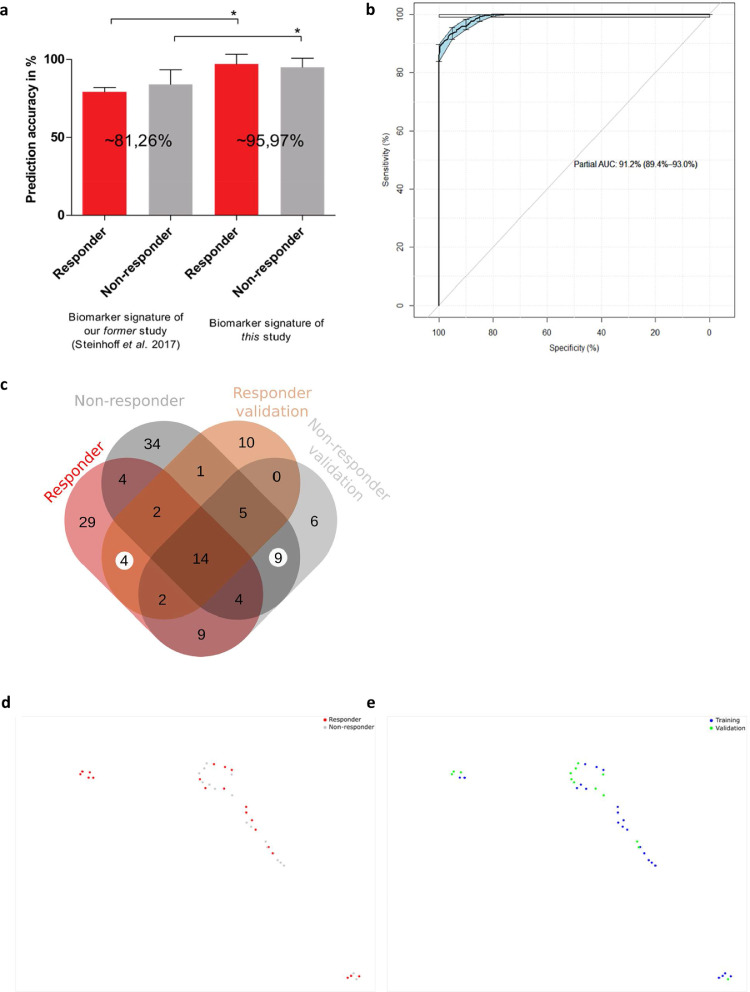
Patient stratification to responder and non-responder. Clustering and SNP signature comparison for the analysis and validation cohort.a: Machine learning accuracy comparison for the supervised prediction of the patient responsiveness using only preoperative data. Results are obtained after feature selection and subsequent prediction with two independent classifiers. The graph shows the true positive prediction results of two ML models (AdaBoost for feature selection and RF for final prediction for the former study and RF and SVM for the current study).The error bars indicate the respective accuracy standard deviation for the constructed models that have been obtained after 100 iterations. * indicates that the 100 model iterations are significant different according to Bonferroni post-hoc test (p<0.01). b: Receiver Operating Characteristics (ROC) curve for the random forest machine learning model. The plot represents the sensitivity (true positive rate) and the specificity (false positive rate) of the model. The area under the ROC curve (AUC) represents the entire area underneath the ROC curve and the confidence intervals (95%CI) are indicated in blue. c: Venn diagram summarizing the identified SNPs in RvsNR for the analysis and validation cohort.d-e: Validation for the clustering with primary cohort (n=23, blue, Rostock trial center biomarker cohort) and independent validation cohort (n=14, green, Hannover center). UMAP representation with k=4 and 2,000 epochs (For interpretation of the references to color in this figure legend, the reader is referred to the web version of this article.).